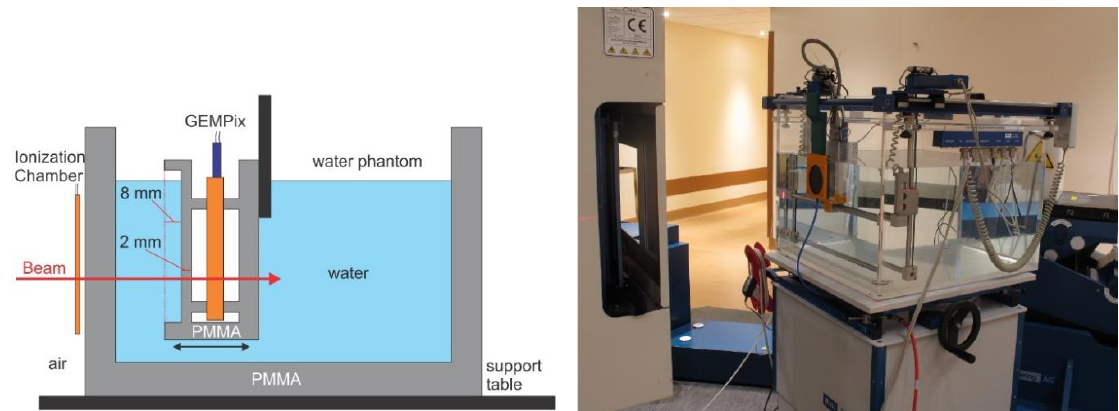
Figure 8. Schematic drawing (( left ), not to scale) and picture ( right ) of the water phantom setup. The beam enters from the left and passes through the reference ionization chamber before entering the water phantom. The GEMPix is inserted in a watertight box, which is mounted on the positioning system of the phantom. Therefore, depth scans are possible by remotely changing the distance between beam entrance window and GEMPix box.